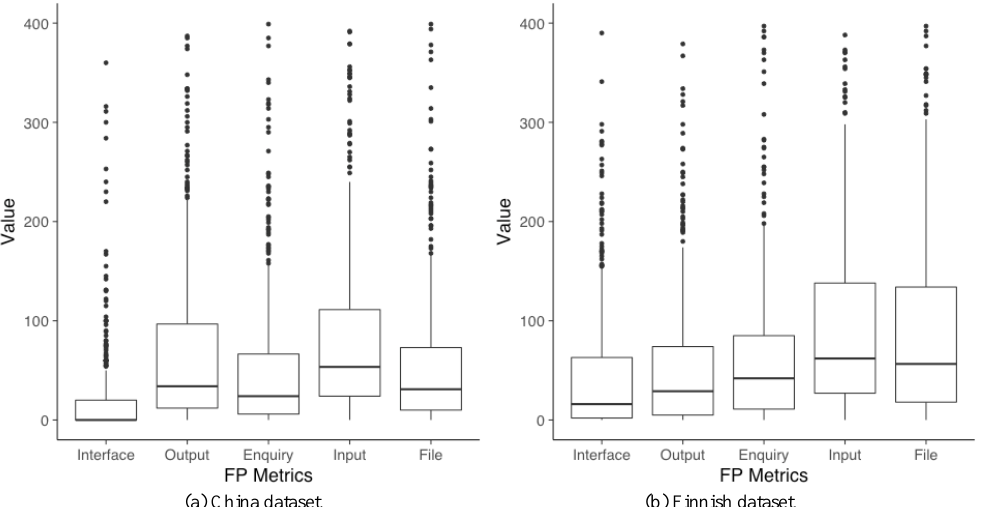
Fig. 4. Boxplots for FP